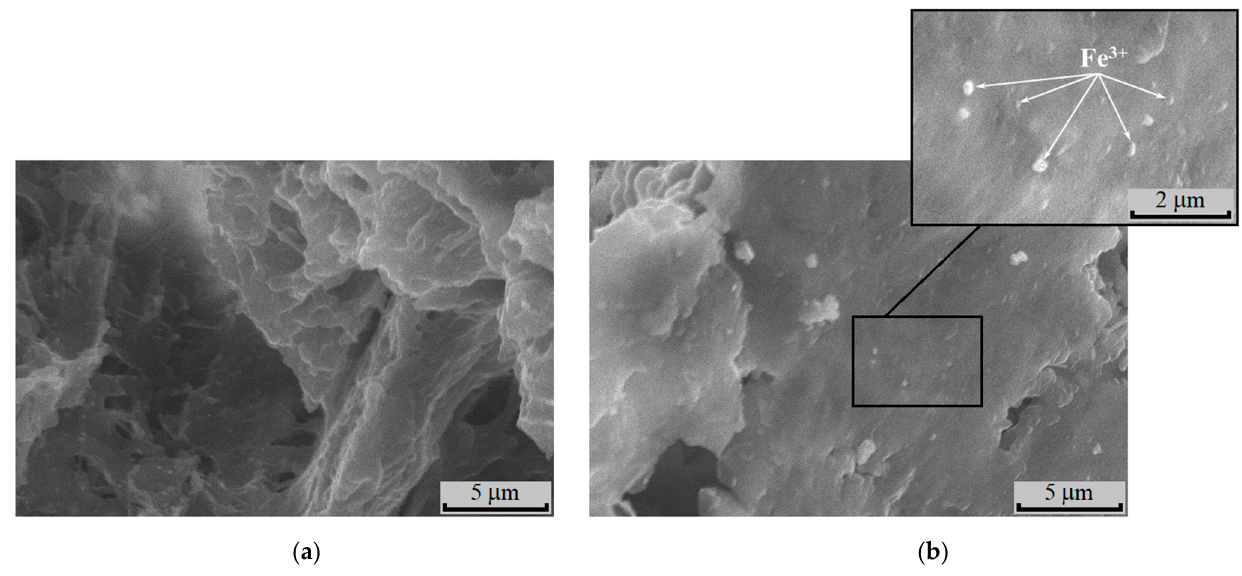
Figure 10. SEM micrographs of the initial films PHB-chitosan (50:50, wt. %) ( a ) and after sorption ( b ) from 0.3 mol/L FeCl 3 solution.